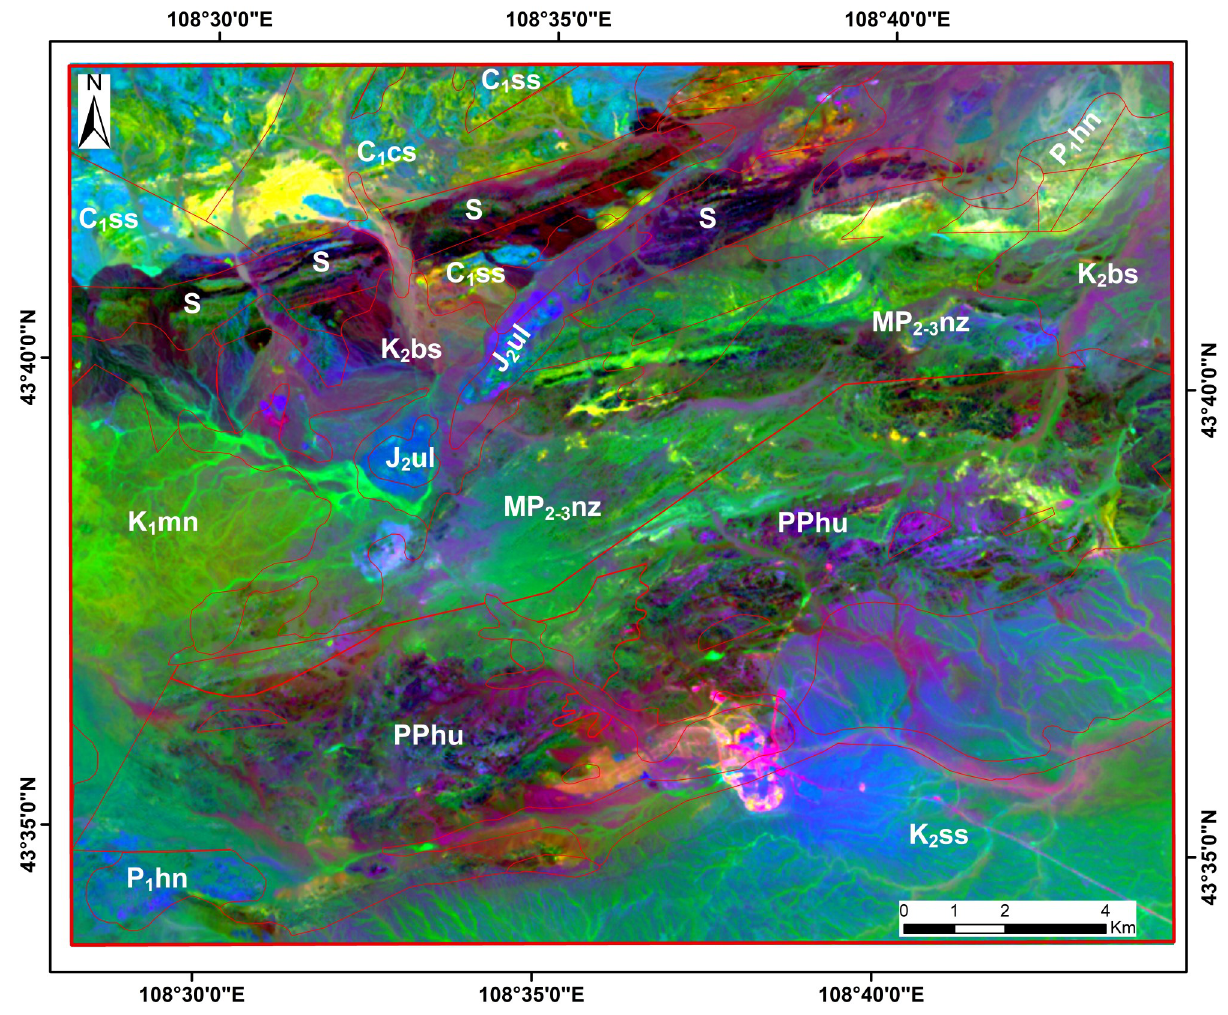
Fig. 7. RGB color composite of PC images Landsat OLI (PC4, PC3,